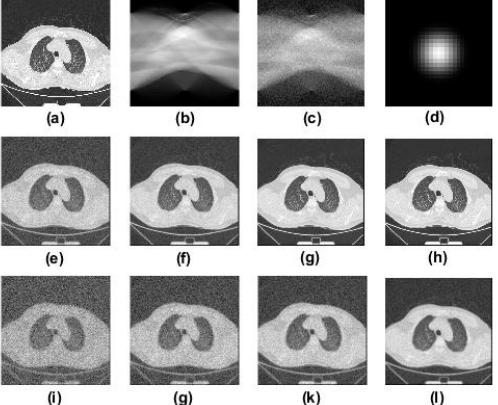
Figure 2. Experimental images and results of the second CT image. The 1st row shows the sharp CT image (left) and the CT noisy projection for 100% of measurements (middle) as well as the 27 × 27 point spread function; the 2nd row shows the blind restoration reconstruction results for 40%, 60%, 80% and 100% of measurements, respectively, from left to right (SNR = 40 dB); the 3rd row shows the blind restoration reconstruction results for 40%, 60%, 80% and 100% of measurements, respectively, from left to right (SNR = 20 dB). ( a ) the sharp CT image; ( b ) the measured noisy projection (SNR = 40 dB); ( c ) the measured noisy projection (SNR = 20 dB); ( d ) the point spread function; ( e ) the reconstruction result (SNR = 40 dB, Sampling ratio = 40%); ( e ) the reconstruction result (SNR = 40 dB, Sampling ratio = 60%); ( f ) the reconstruction result (SNR = 40dB, Sampling ratio = 80%); ( g ) the reconstruction result (SNR = 40 dB, Sampling ratio = 100%); ( h ) the reconstruction result (SNR = 20 dB, Sampling ratio = 40%); ( i ) the reconstruction result (SNR = 20 dB, Sampling ratio = 60%); ( j ) the reconstruction result (SNR = 20 dB, Sampling ratio = 80%); ( k ) the reconstruction result (SNR = 40 dB, Sampling ratio = 40%); ( l ) the reconstruction result (SNR = 20 dB, Sampling ratio =